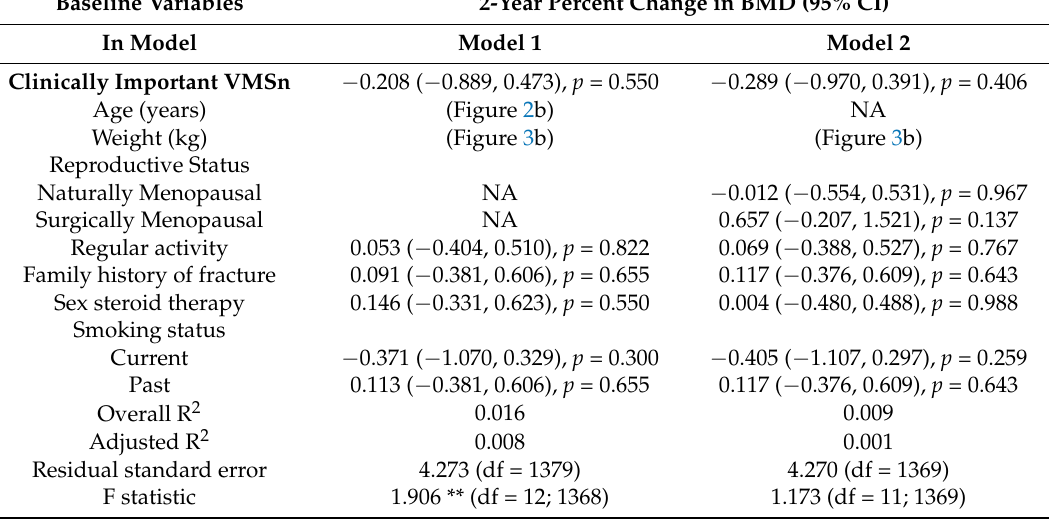
Table 3. Multivariable Linear Regression Models without interactions for 2-year Percentage Change in areal BMD (95% confidence intervals) at Femoral Neck in Women ages 43–63 in the Canadian Multicentre Osteoporosis Study (CaM os